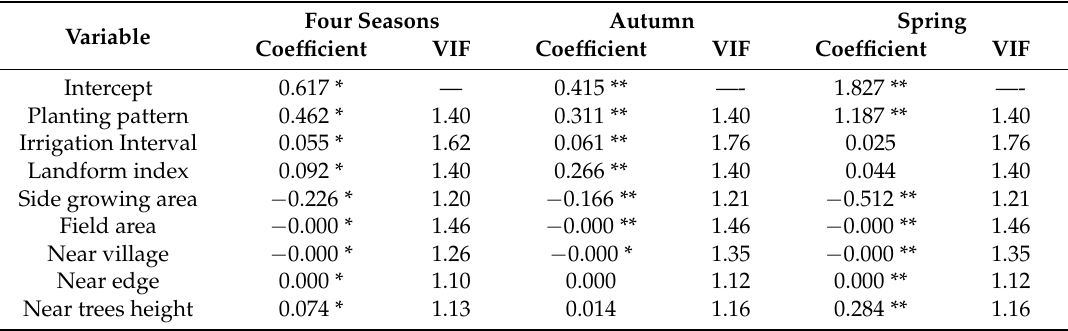
Table 2. Coefficient and variance inflation factors (VIF) of pooled four seasons, autumn and spring means infestation with different environmental factors.